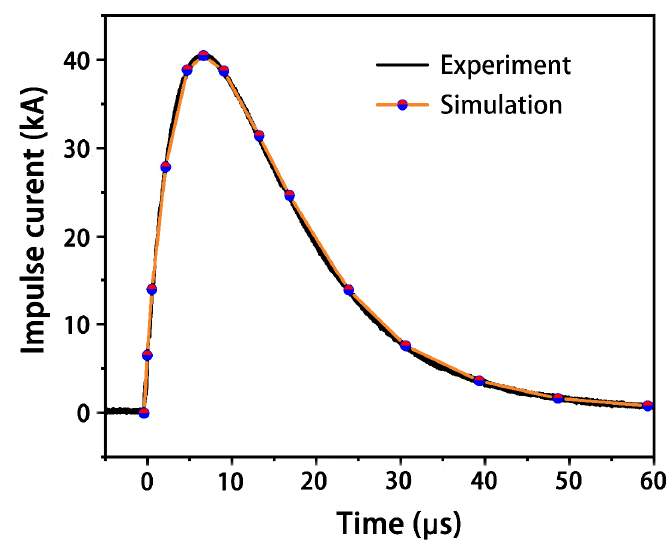
Figure 3. Experimentally applied current of component A.